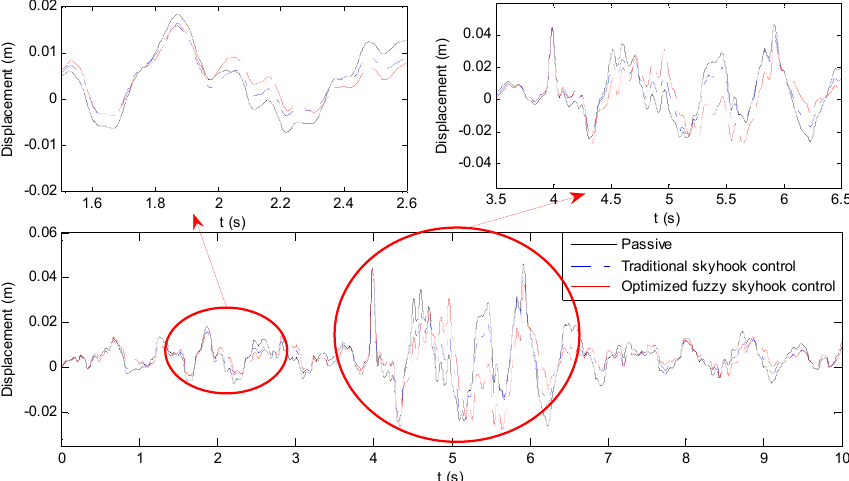
Energies 2021 , 14 , x FOR PEER REVIEW Figure 21. Comparison of the suspension dynamic deflections using the three control methods under potholed road excitation.